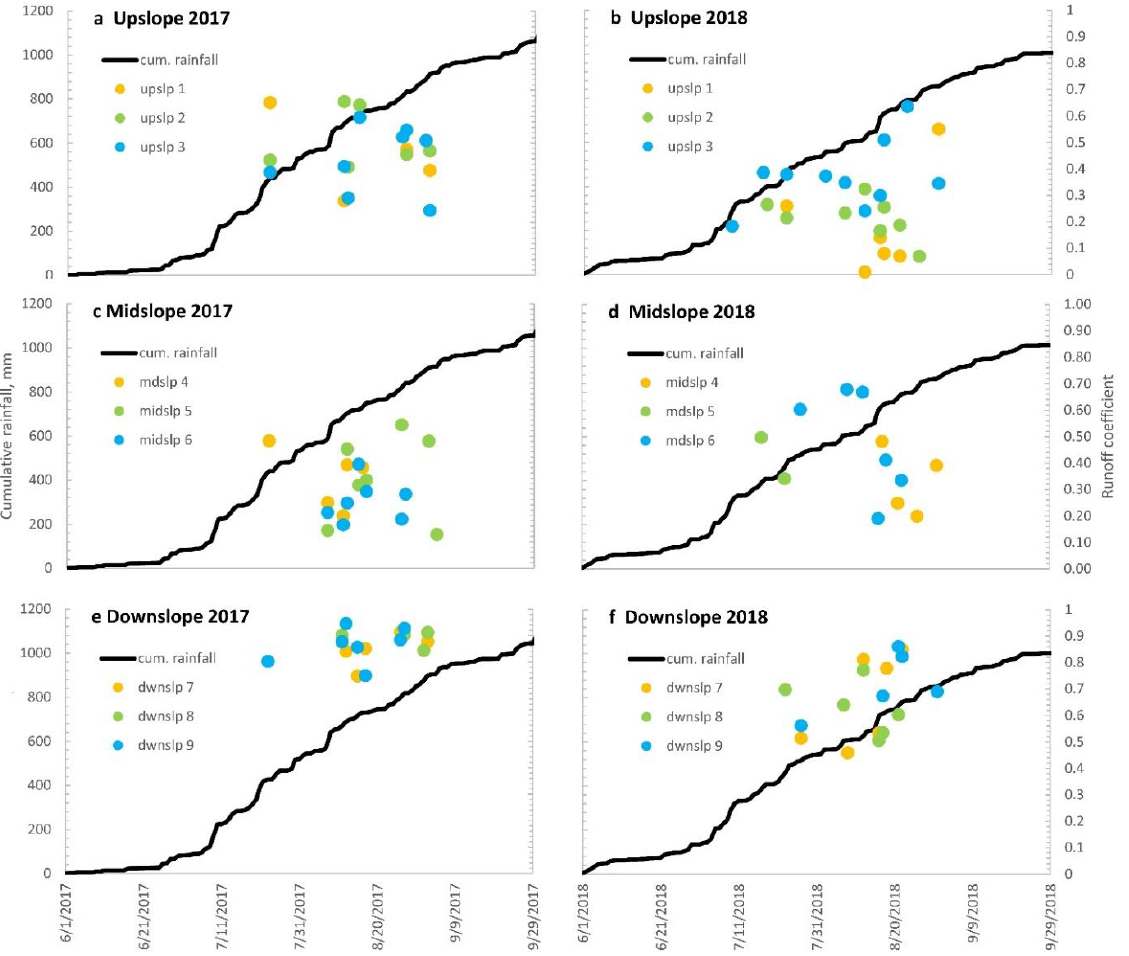
Figure 4. Cumulative precipitation and the runoff coefficients of the individual storms for the upslope, midslope, and downslope positions in the 2017 and 2018 rain phases. The symbols indicate the runoff coefficients for the upslope ( a ) in 2017 and ( b ) in 2018; the midslope ( c ) in 2017 and ( d ) in 2018 and downslope ( e ) in 2017 and ( f ) in 2018.